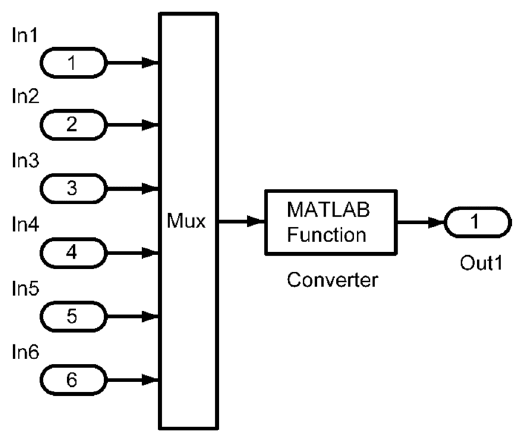
Figure 8. Power converter module.